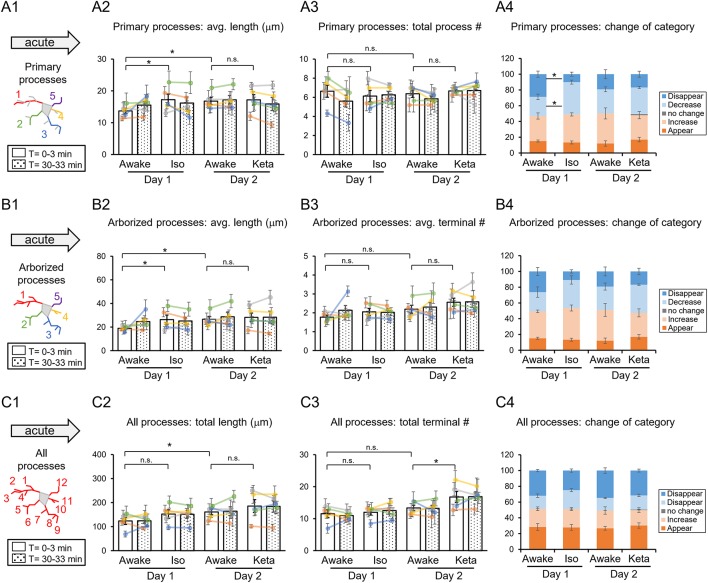
Dynamics of microglial processes in awake, isoflurane (Iso)- and ketamine (Keta)-anesthetized mice in acute experiments (5 animals). Schematic drawing of microglial processes (represented in color-matching mode): primary processes (A1), arborized processes (B1) and all processes (C1). Quantification of the average or total length and the total terminal number per primary process (A2,A3), arborized process (B2,B3) and all processes (C2,C3). The dots show individual mean values ± SEMs per animal, the values from the same animal are connected by lines (B2,B3,C2,C3). White and dotted bars show means ± SEMs for all animals at time = 0 and 30 min. Processes are categorized according to morphological changes, such as “Disappear,” “Decrease,” “No change,” “Increase,” or “Appear” (A4,B4,C4). *p < 0.05, n.s., non-significant, one-way RM nested ANOVA, Newman-Keuls post-hoc test for A2–C2; Kruskal-Wallis test with Conover-Iman multiple comparison tests for A3–C3 and A4–C4.